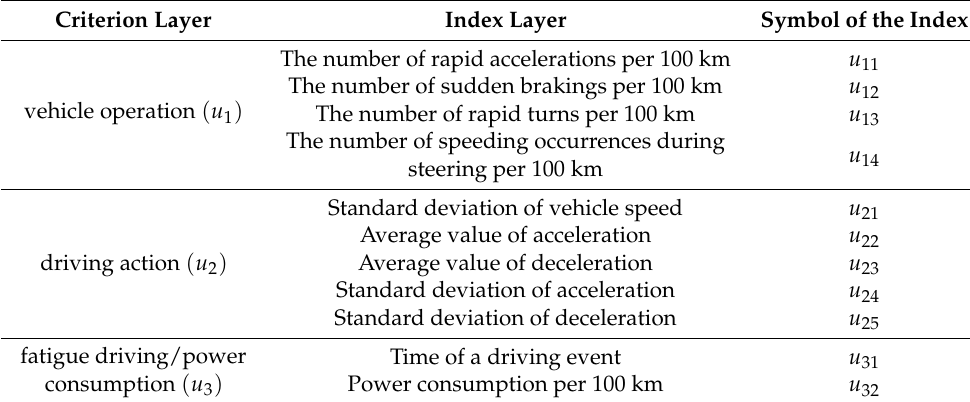
Table 6. The detailed index structure of driving behaviour